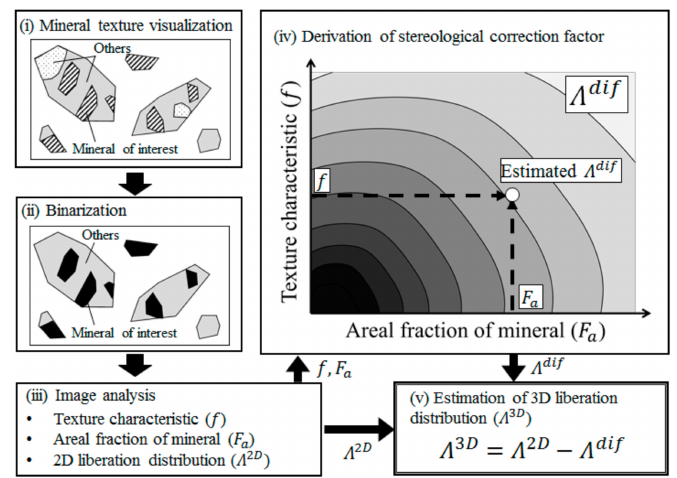
Figure 1. Schematic diagram of the stereological correction method.